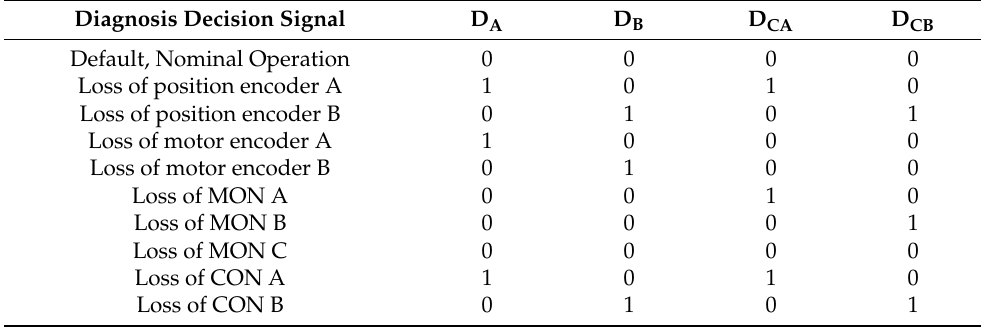
Table 7. Multiple model monitors and the diagnosis decision signals.